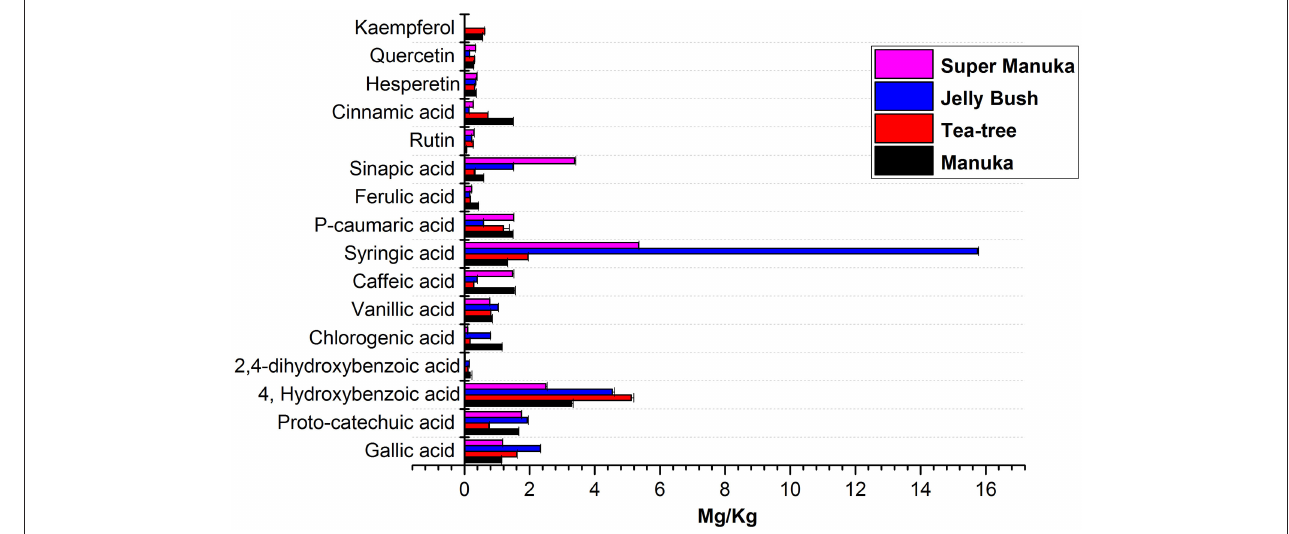
FIGURE 6 | Comparative analysis of phenolic compounds in Leptospernum origin honeys.